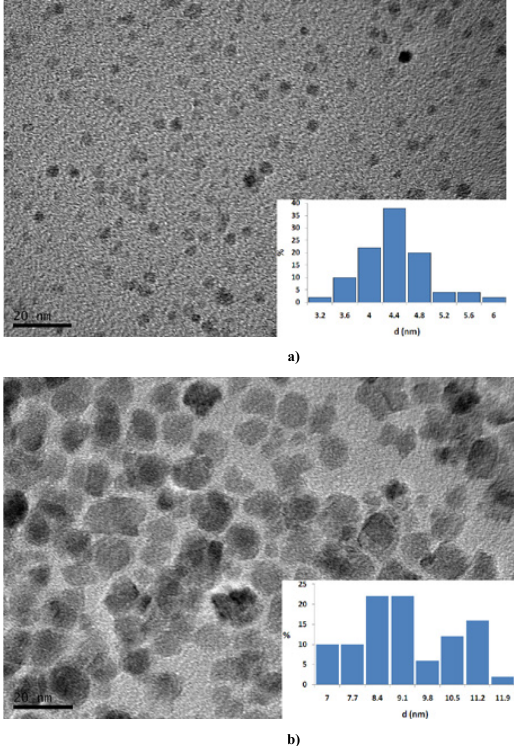
Fig. 1. TEM image of samples synthesized in the presence of a) 10 mmole TMAH (sample A) and b) 15 mmole TMAH (sample